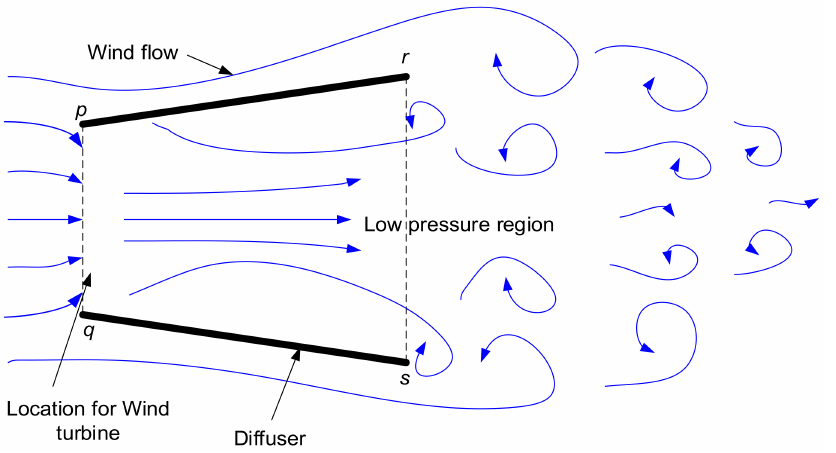
Figure 3. Wind flow through the diffuser.